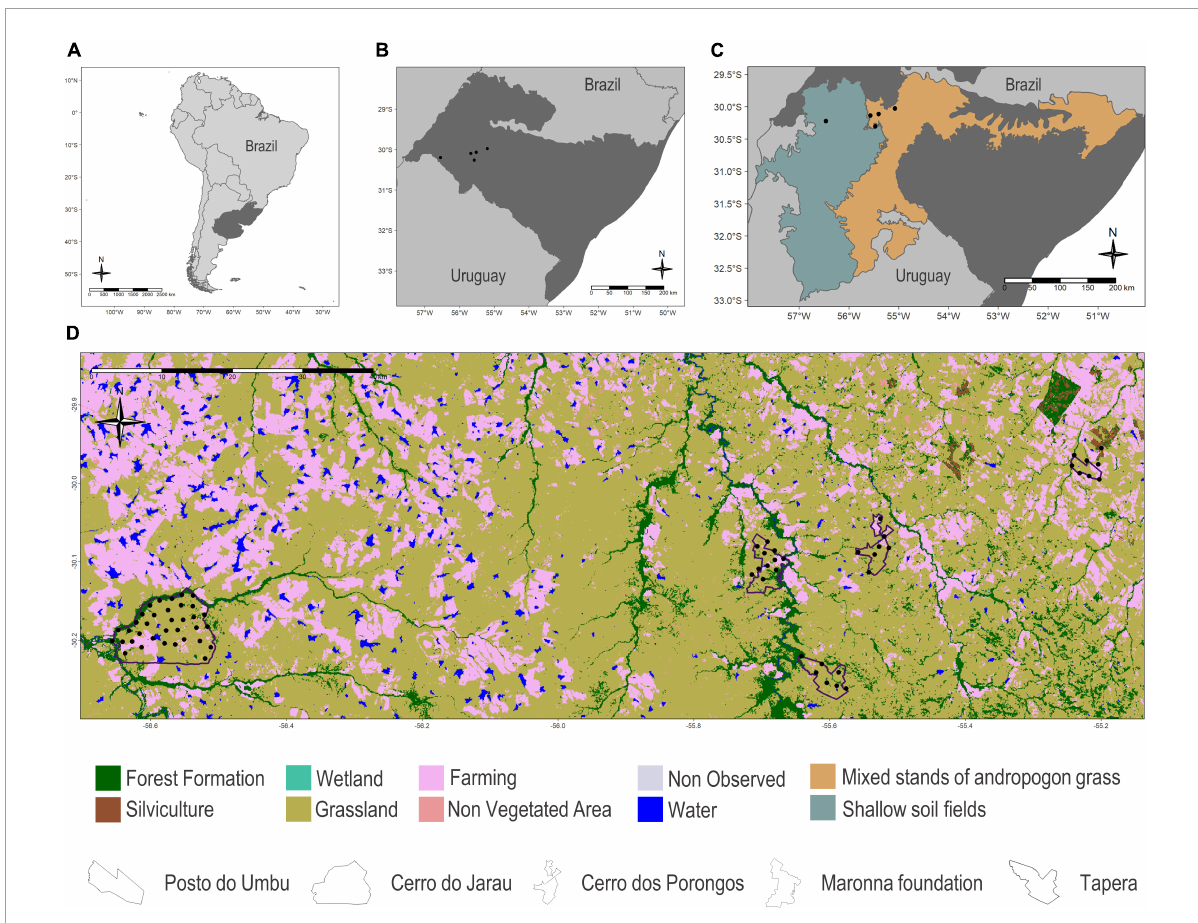
FIGURE1 (A) Location of the Brazilian-Uruguayan savanna ecoregion within South America in dark grey. (B) Location of the five areas in the municipalities of Alegrete, Cacequi, and Quaraí, Brazilian Pampa, for bat acoustic sampling during the spring and summer of 2019 and 2020. (C) The two main physiognomies occurring in the Brazilian and Uruguayan grasslands: in turquoise the shallow soil fields and in orange the mixed stands of andropogon grass. (D) Land use and land cover map (MapBiomas Pampa Sudamericano Project, 2021) for the five sampled areas (Posto do Umbu, Tapera, Cerro do Jarau, Maronna foundation, and Cerro dos